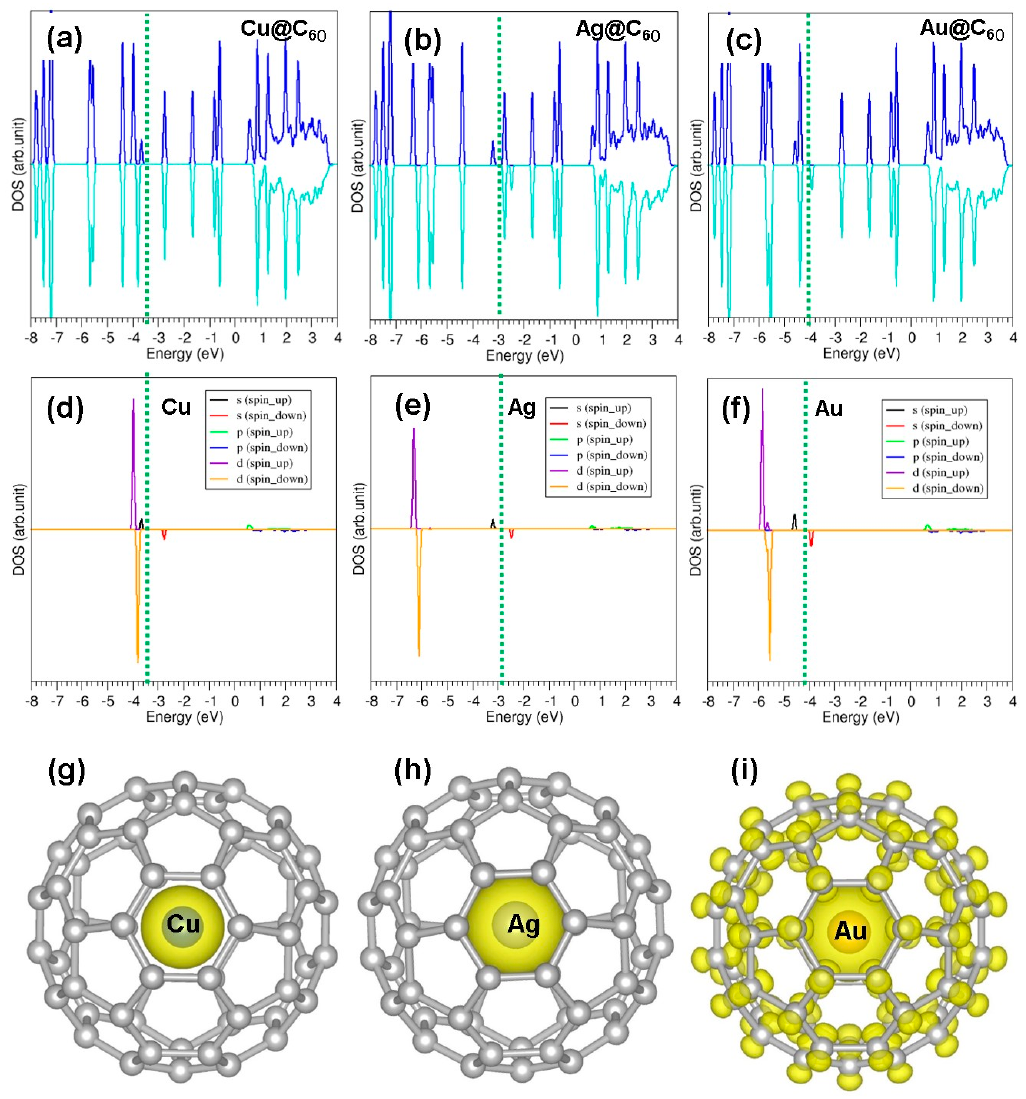
Figure 4. ( a – c ) Total DOSs for Cu, Ag and Au within a C 60 molecule, respectively; ( d – f ) atomic doses for Cu, Ag and Au within a C 60 molecule, respectively; and ( g – i ) charge density distributions around the encapsulated metal atoms for Cu, Ag and Au within a C 60 molecule,